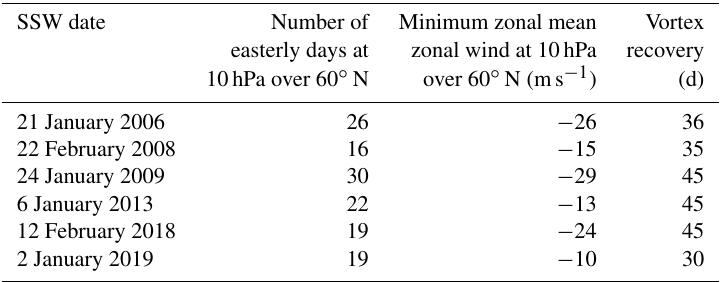
Table 2. SSW dates, duration, magnitude, and the duration of polar vortex from 2004 to 2020. The number of easterly days at 10hPa over 60 ◦ N is shown as the duration SSW. The magnitude of SSWs is defined by the minimum zonal mean zonal wind at 10hPa over 60 ◦ N during each SSW. The total number of easterly days associated with the event is not necessarily consecutive. The duration of polar vortex recovery is defined as the number of days that the zonal averaged EPV takes to reach the climatological zonal EPV. SSW date Number of Minimum zonal mean Vortex easterly days at zonal wind at